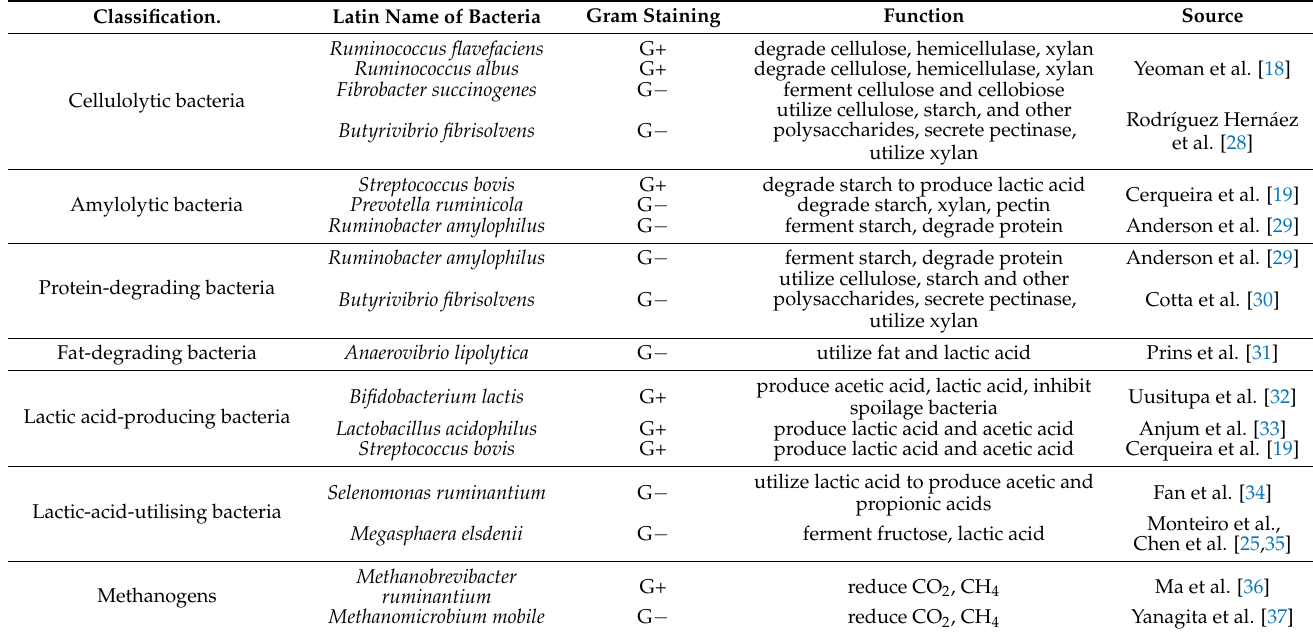
Table 1. Classification of major rumen functional